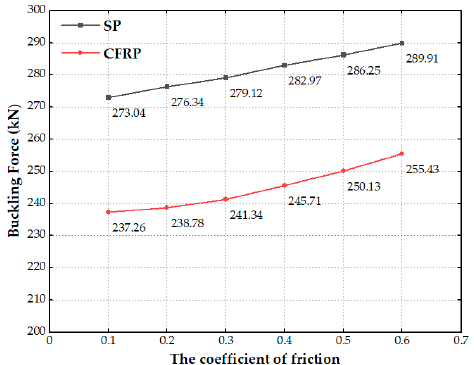
Figure 15. Buckling force with different friction coefficients.